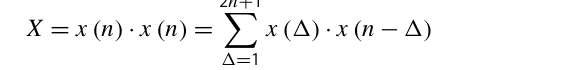
Fig. 4. Top: convolution curves for the validation data with itself (ISR-ISR) and with the MIDAS results (ISR-MIDAS). Bottom: the difference between the these curves. The generally higher values of the ISR-MIDAS curve indicate that MIDAS is overestimating Nm F2 in many